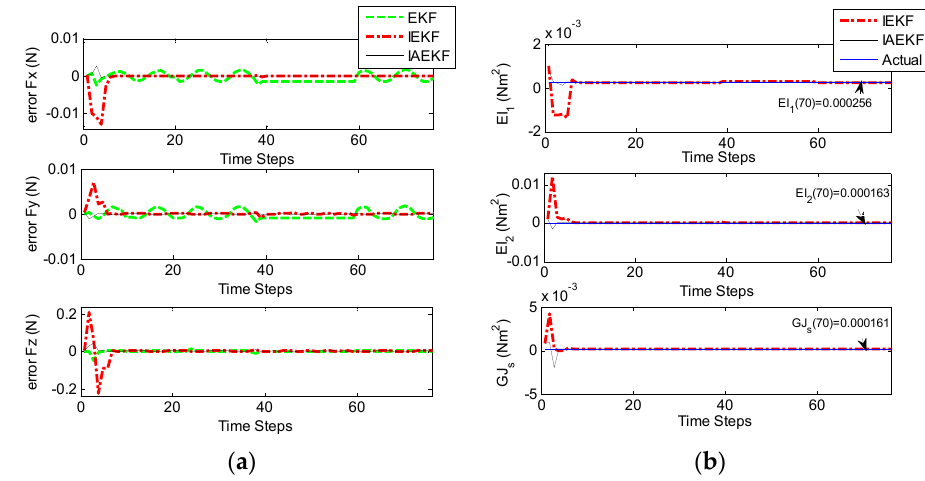
Figure 7. CFSE estimation with the applied tip contact force in all directions including sudden changes by EKF-based algorithms: ( a ) Contact force estimation error; ( b ) Stiffness estimation. Table 6. Computational time for EKF-based estimates with l i “ 10, M “